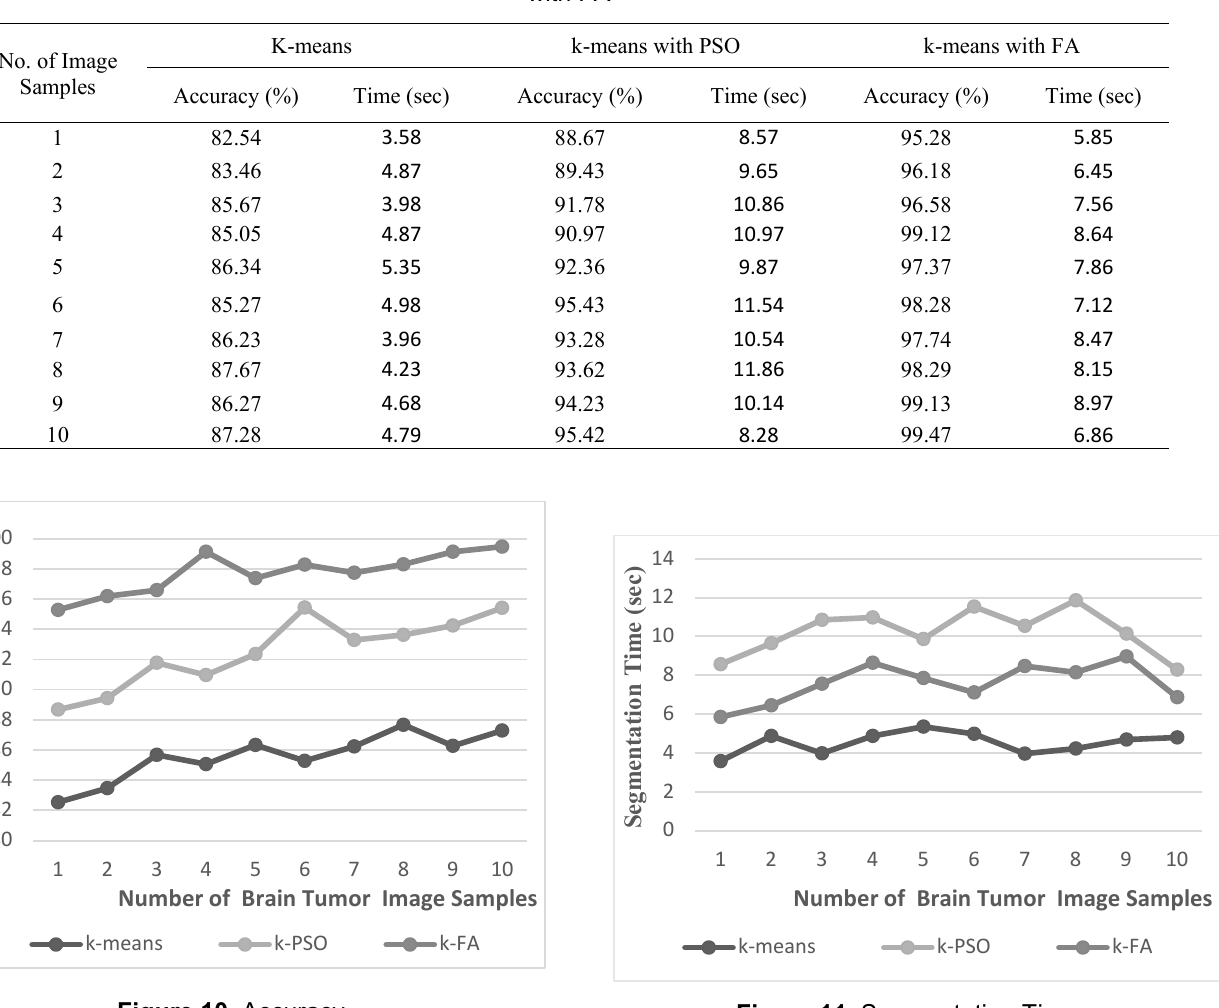
Figure 10. Accuracy Figure 11. Segmentation Time In the evaluation process, the segmentation time required to complete the image segmentation process has also been computed. Figure 11 represents the graph of a number of brain tumor image samples plotted against the segmentation time utilized to complete the image segmentation process using k-means, k-means with PSO, and k-means with FA. The average segmentation time required to complete the segmentation process of 10 brain tumor image samples is 4.53secs using k-means that get increased to 7.6secs and 10.23secs by combining k-means with FA and PSO, respectively. It is observed that on an average k-means combination with FA took 2.63secs less than the combination of k-means with PSO. Hence, k- means with FA is found to be less time consuming with more relevant results. Among the presented image segmentation approaches such as K-means, K-means with against the two